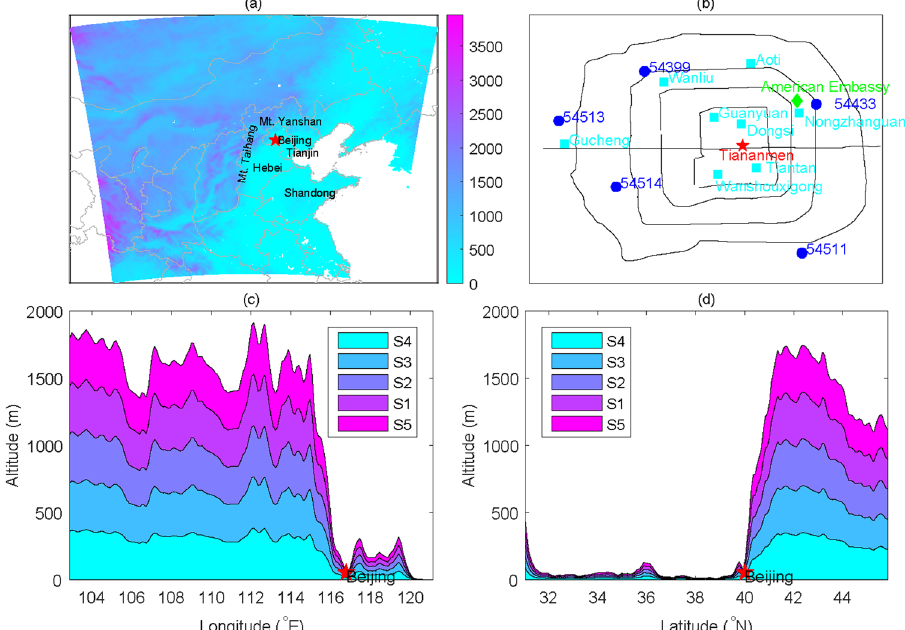
Figure 1. A map showing the topography of northern China and the spatial domain of the simulations ( a ); environmental monitoring sites operated by the Ministry of Environmental Protection of the People’s Republic of China (cyan squares) and American Embassy (green diamond) and meteorological stations operated by China Meteorological Administration (blue dots) in downtown Beijing ( b ); the topographic profiles of altitude-longitude along 39.5–40.5°N ( c ) and altitude-latitude along 116–117°E ( d ) in the different sensitivity